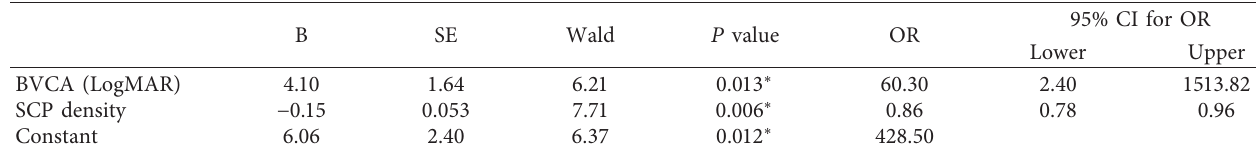
Table 2: Regression coefficients in the binary logistic regression model.